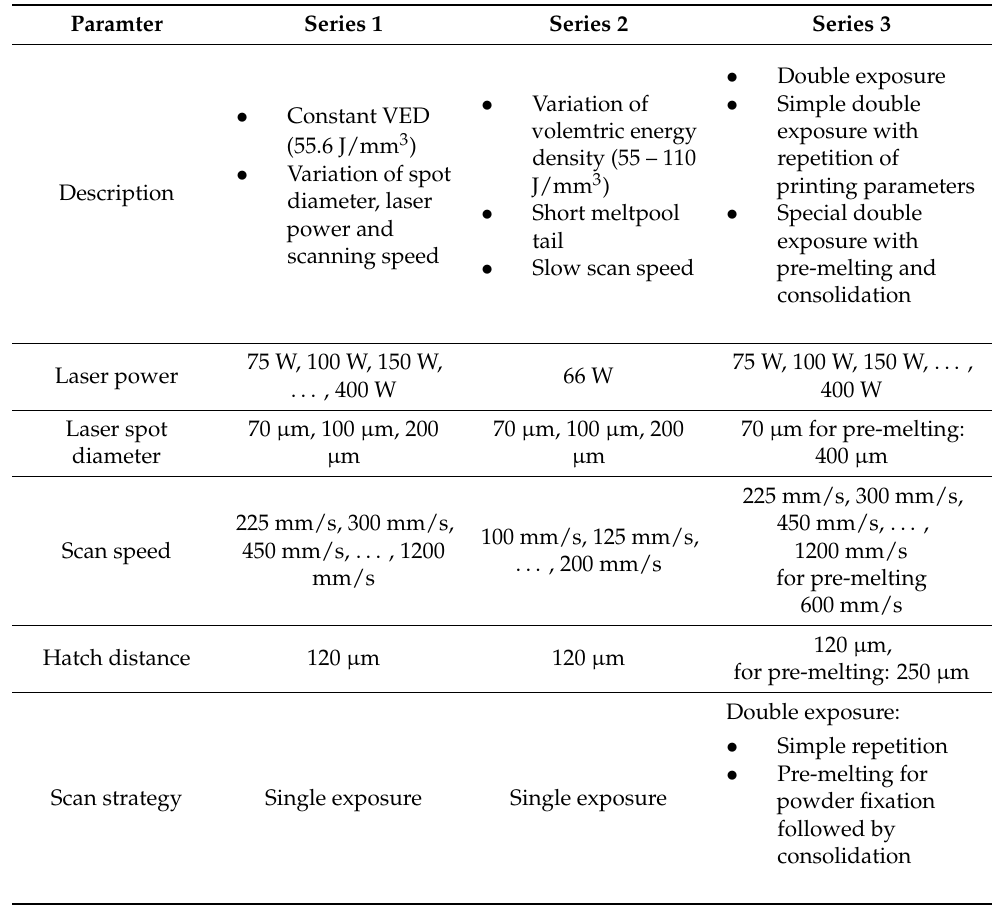
Table 2. Experimental